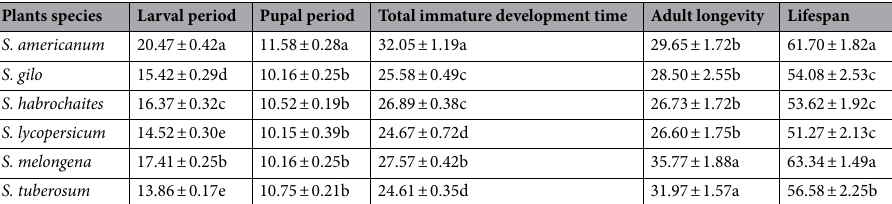
Table 1. Means (± SE) of larval and pupal developmental periods (days), average longevity of males and females (days), and lifespan (days) of T. absoluta when offered different solanaceous species. Results followed by different letters were significantly different according to the Scott Knott test ( p < 0.05) when comparing plant species. Data from C. annuum , C. chinense and S. aculeatissinum were not included in the table because of the high mortality rate of the larvae, making it impossible to continue the life table study of insects on these host plants.